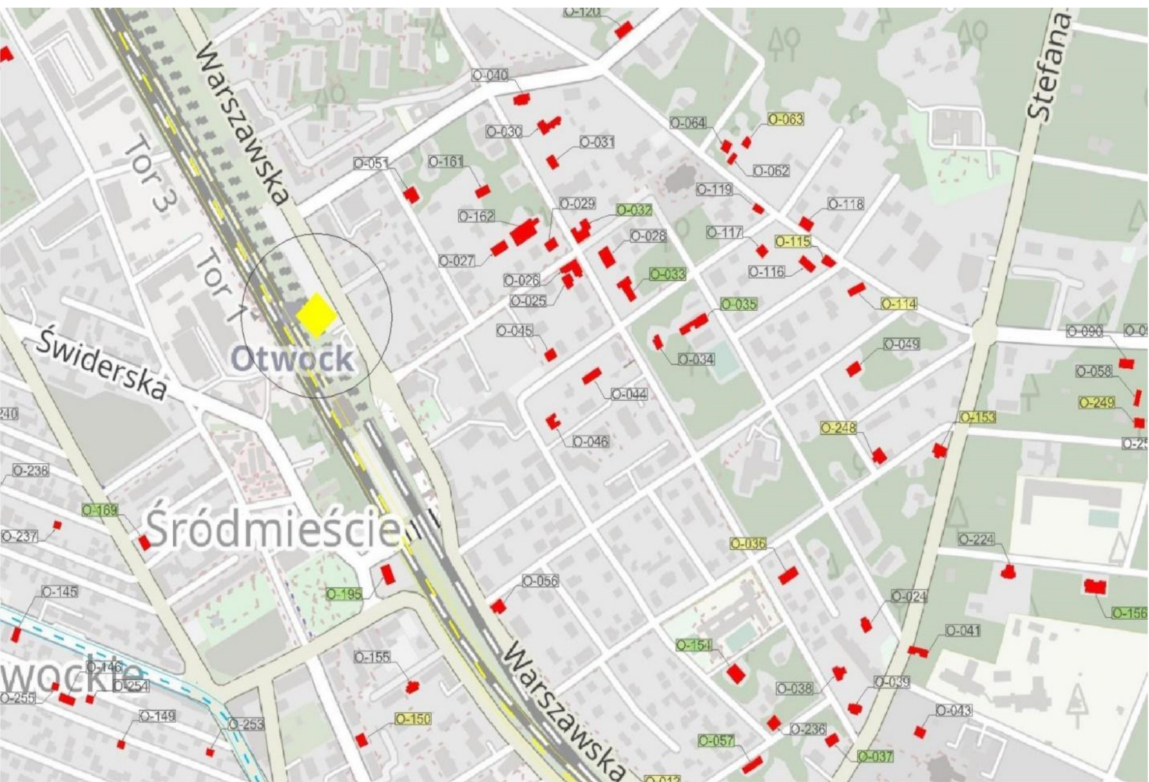
Figure 9. A fragment of the map of Otwock, indicating buildings of high scientific, artistic and historical value: at least two high values (green), one high value (yellow), based on